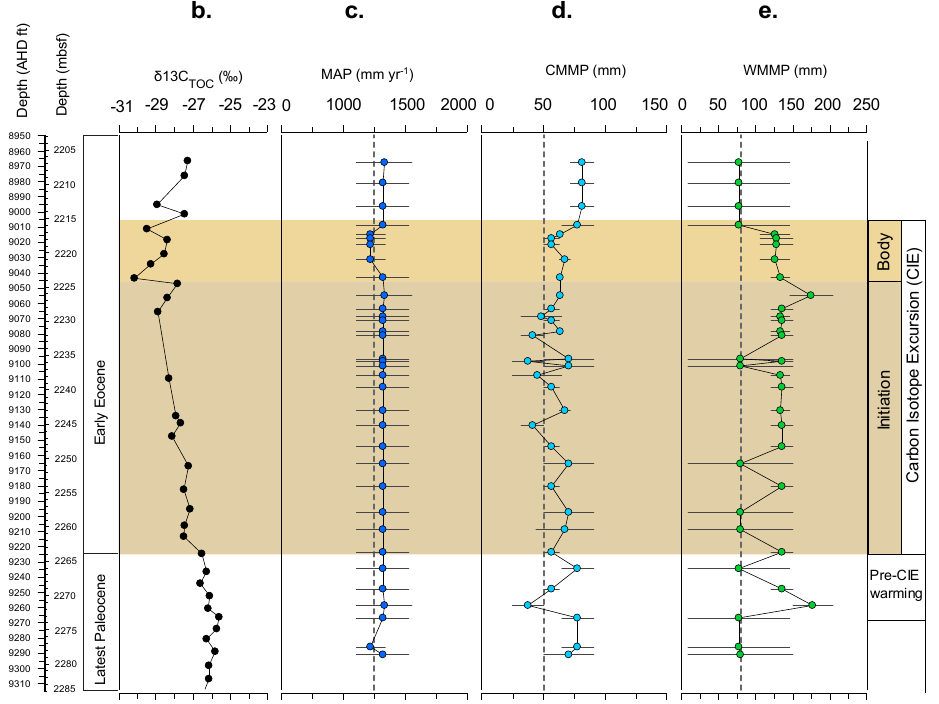
Fig. 5. Record of Paleocene–Eocene precipitation data from well 22/11-N1: (a) depth and age, (b) carbon isotope data ( δ 13 C TOC ) , (c) MAP, (d) CMMP, and (e) WMMP. (c–e) Horizontal bars and shaded area represent the minimum and maximum estimate returned from the